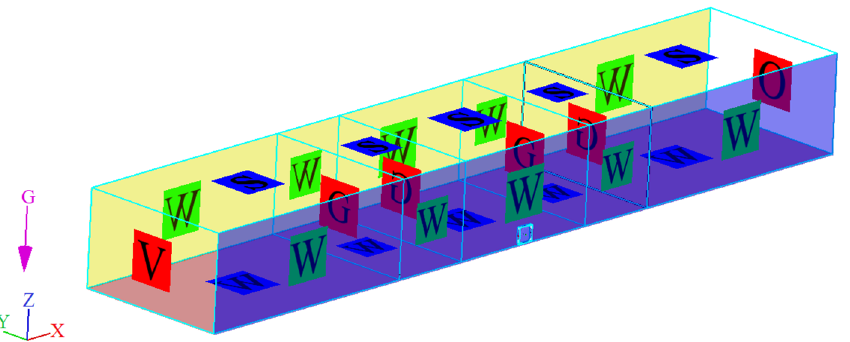
Figure 20. Boundary conditions in the simulated channel.